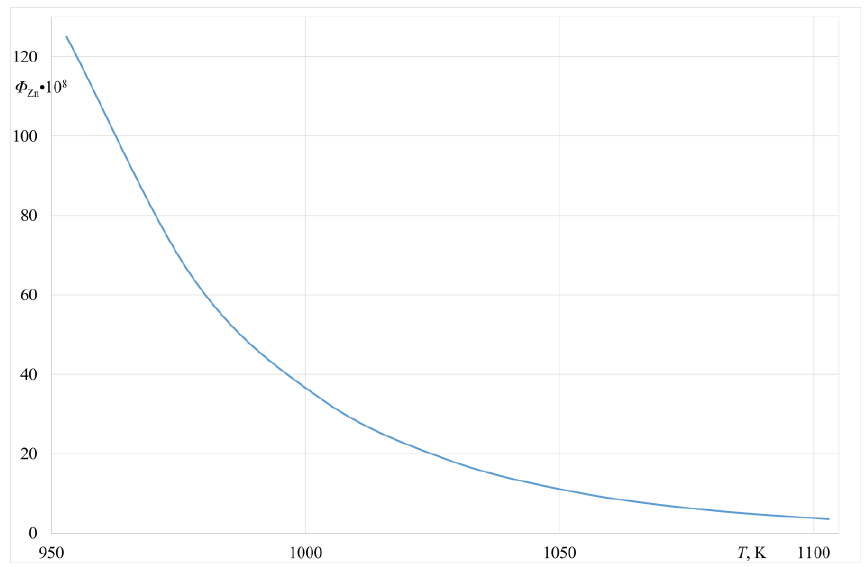
Figure 4. Φ volatility ratio for the Al-Zn alloy (6.3% wt.% Zn).